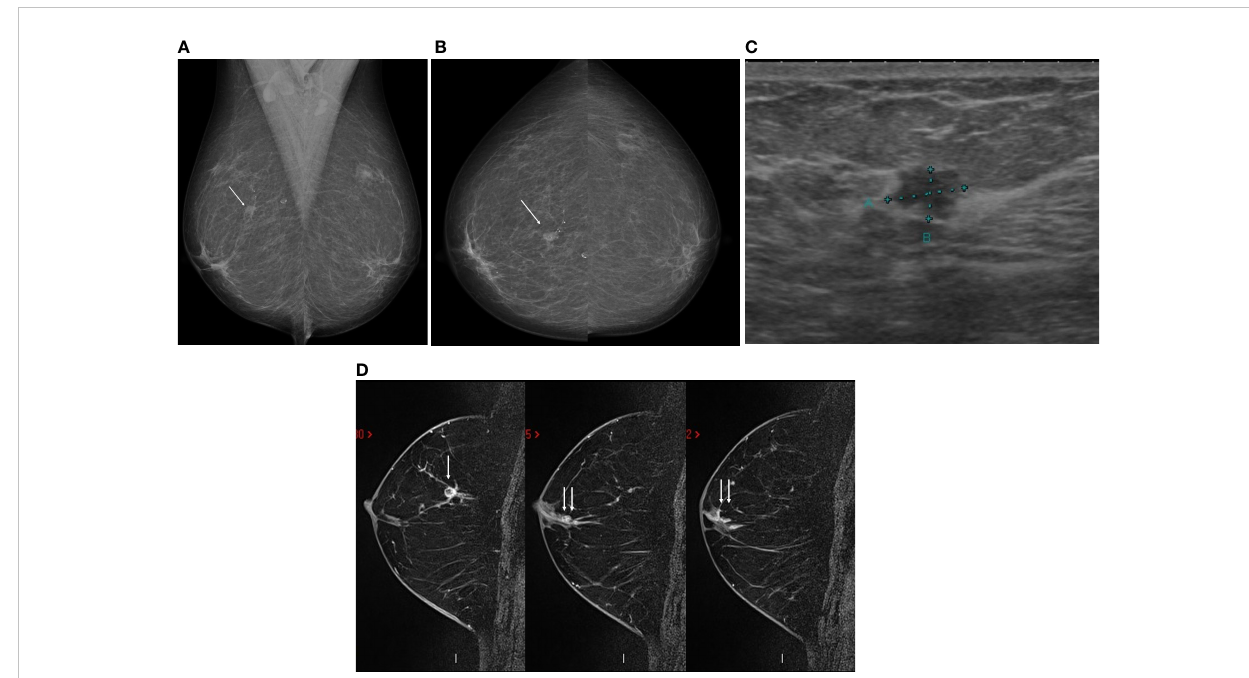
FIGURE 1 A 58-year-old asymptomatic patient underwent mammography in the mediolateral oblique (A) and cranio-caudal (B) views, which showed an irregular nodule, low density and indistinct margins in the middle third of the upper quadrants of the right breast (arrow). Ultrasound showed an irregular, hypoechoic nodule, with non-circumscribed margins, parallel to the skin, with no sound change in this topography (C) , with percutaneous biopsy demonstrating invasive ductal carcinoma, moderate grade, negative for estrogen and progesterone receptors (Luminal A). Magnetic resonance imaging for staging con fi rmed the nodule at the junction of the upper quadrants of the right breast (arrow), in addition to demonstrating non-nodular enhancement extending from the nodule to the papilla (double arrow), con fi rmed as ductal carcinoma in situ (D) .